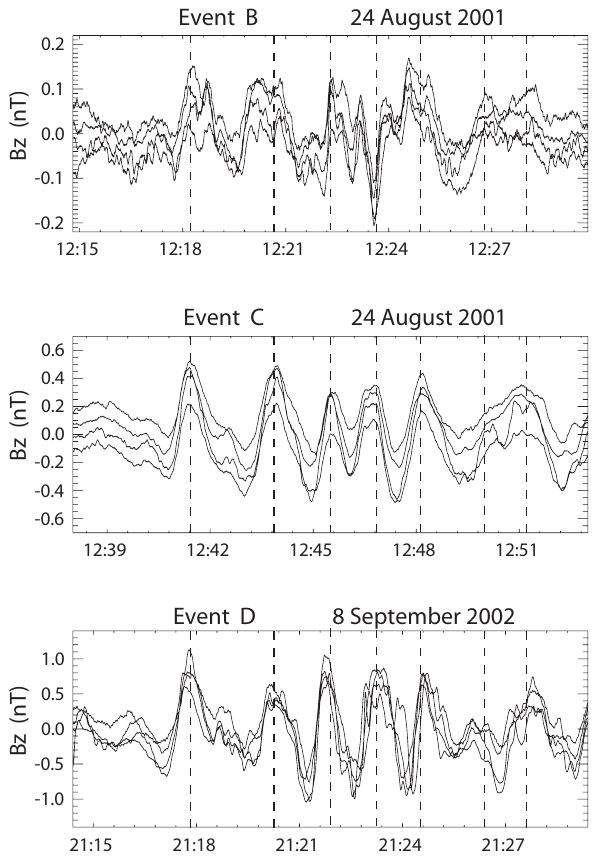
Fig. 9. Cluster (1, 2, 3, 4) magnetic field data ( B z in GSM) of three periodic TCRs on 24 August 2001 and on 8 September 2002. Data were averaged (4s) and detrended (150s). The vertical dashed lines emphasize the similar periodicity of the events even though they occurred on different days. Note that the time periods of each event cover 15min for better